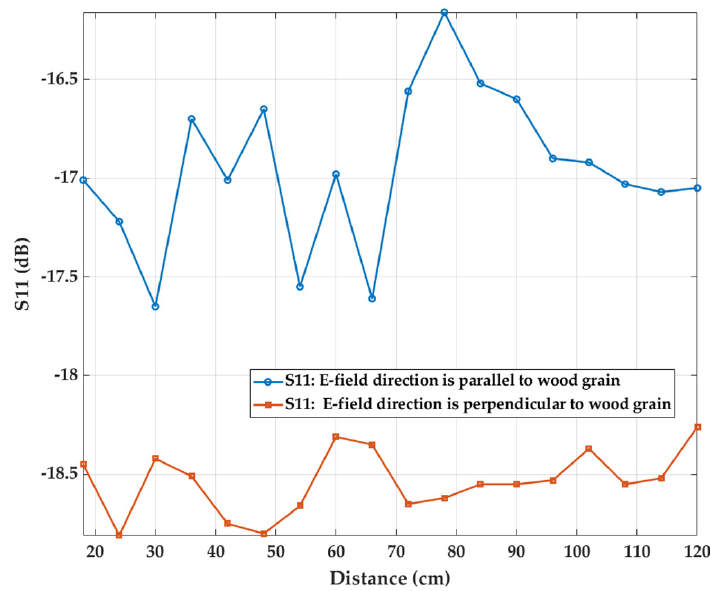
Figure 5. S 11 reflection measurements along the 120 cm wood sample. The mean and standard deviations in these measurements were − 17.0 (0.4) dB for parallel polarization and − 18.5 (0.2) dB for perpendicular polarization.